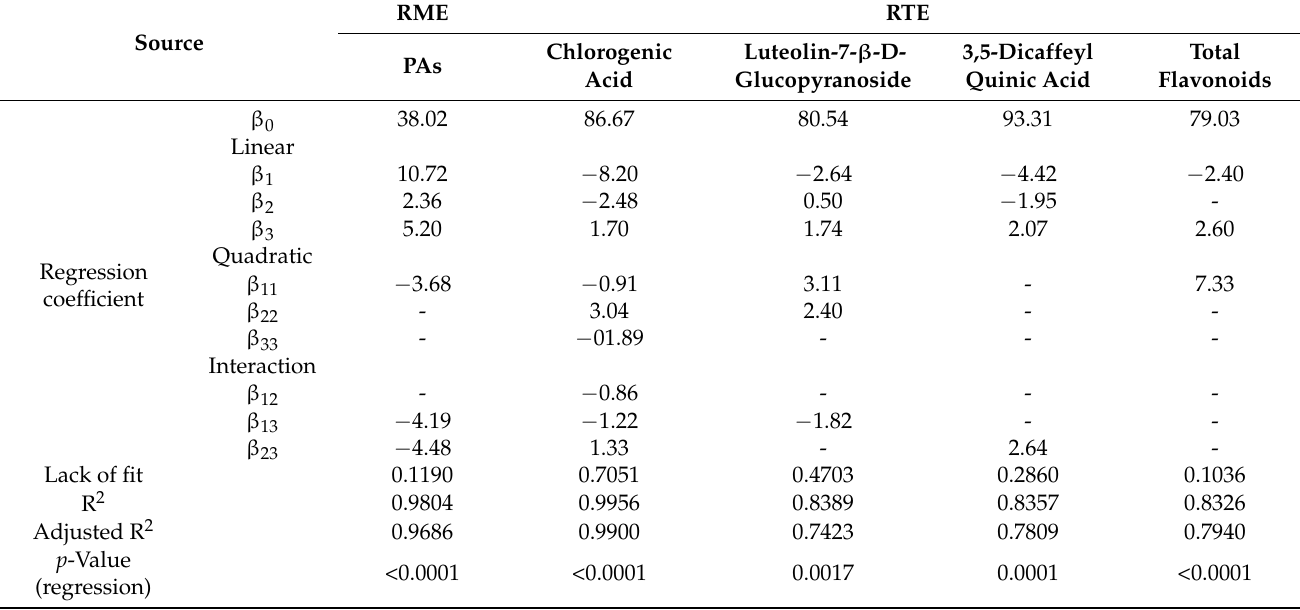
Table 2. Results of regression coefficients and final model efficiency analysis.